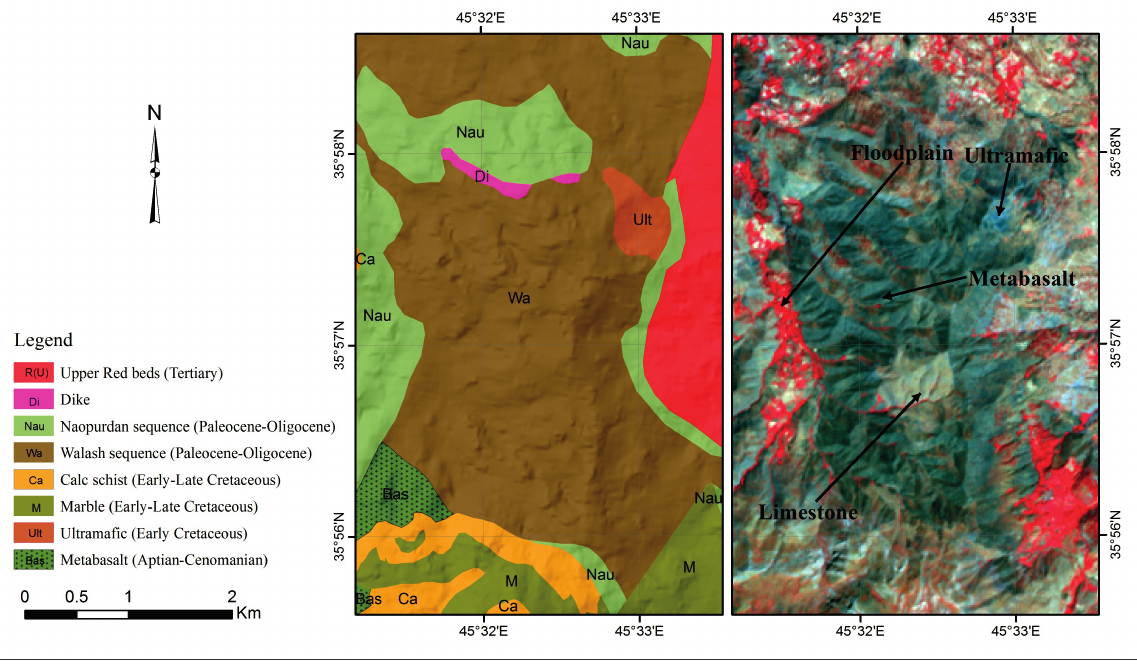
Figure 10. ( A ) Thrust fault overlapping ASTER data R3:G2:B1, acquired on 24 August 2003 ( B ) discriminated classes from combined layers ( i.e. , ASTER reflectance and, layers derived from ASTER and DEM